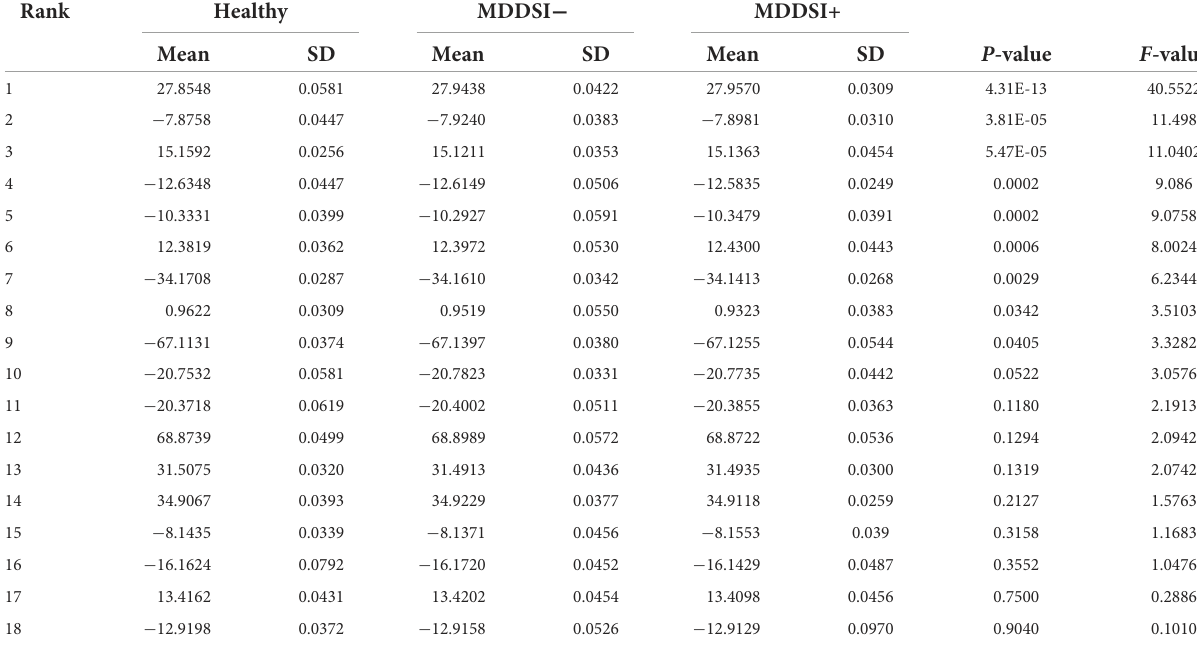
TABLE 3 Range (Mean ± standard deviation) of features ranked using ANOVA after Marginal Fisher Analysis (MFA) feature